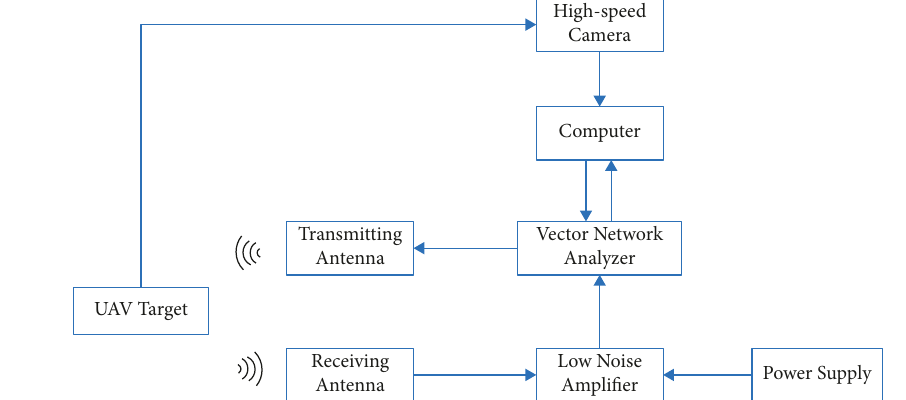
Figure 8: The experimental system.